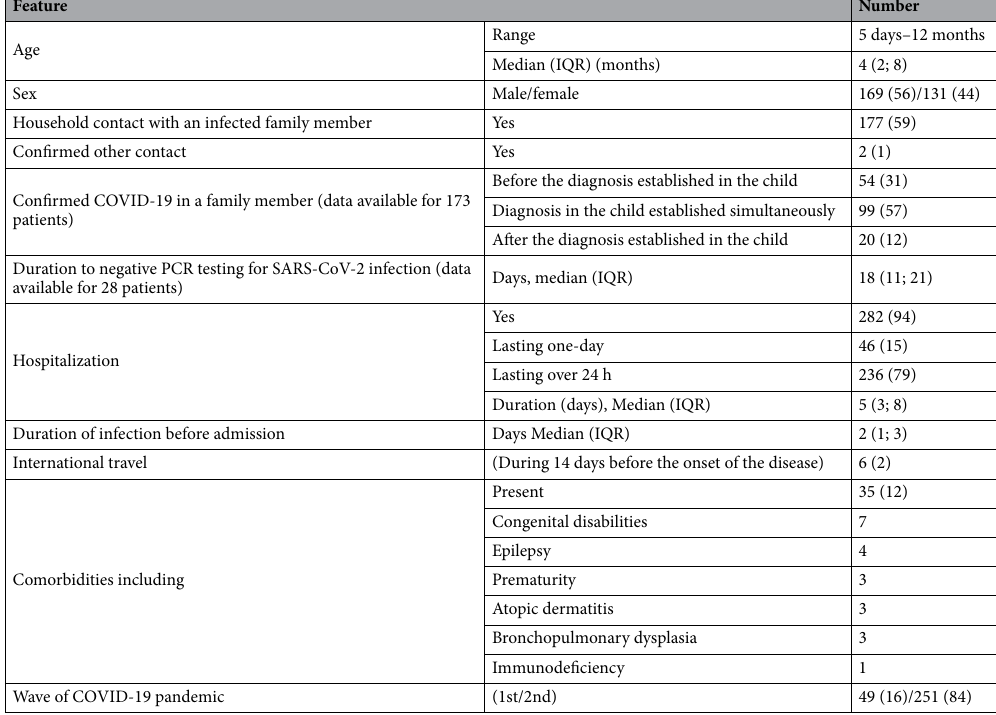
Table 1. Baseline characteristics of the study group ( N = 300). Data are presented as Number (%), unless otherwise indicated.